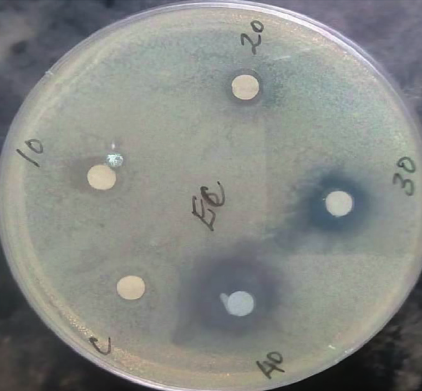
Figure 2: Zone of inhibition of [NiL